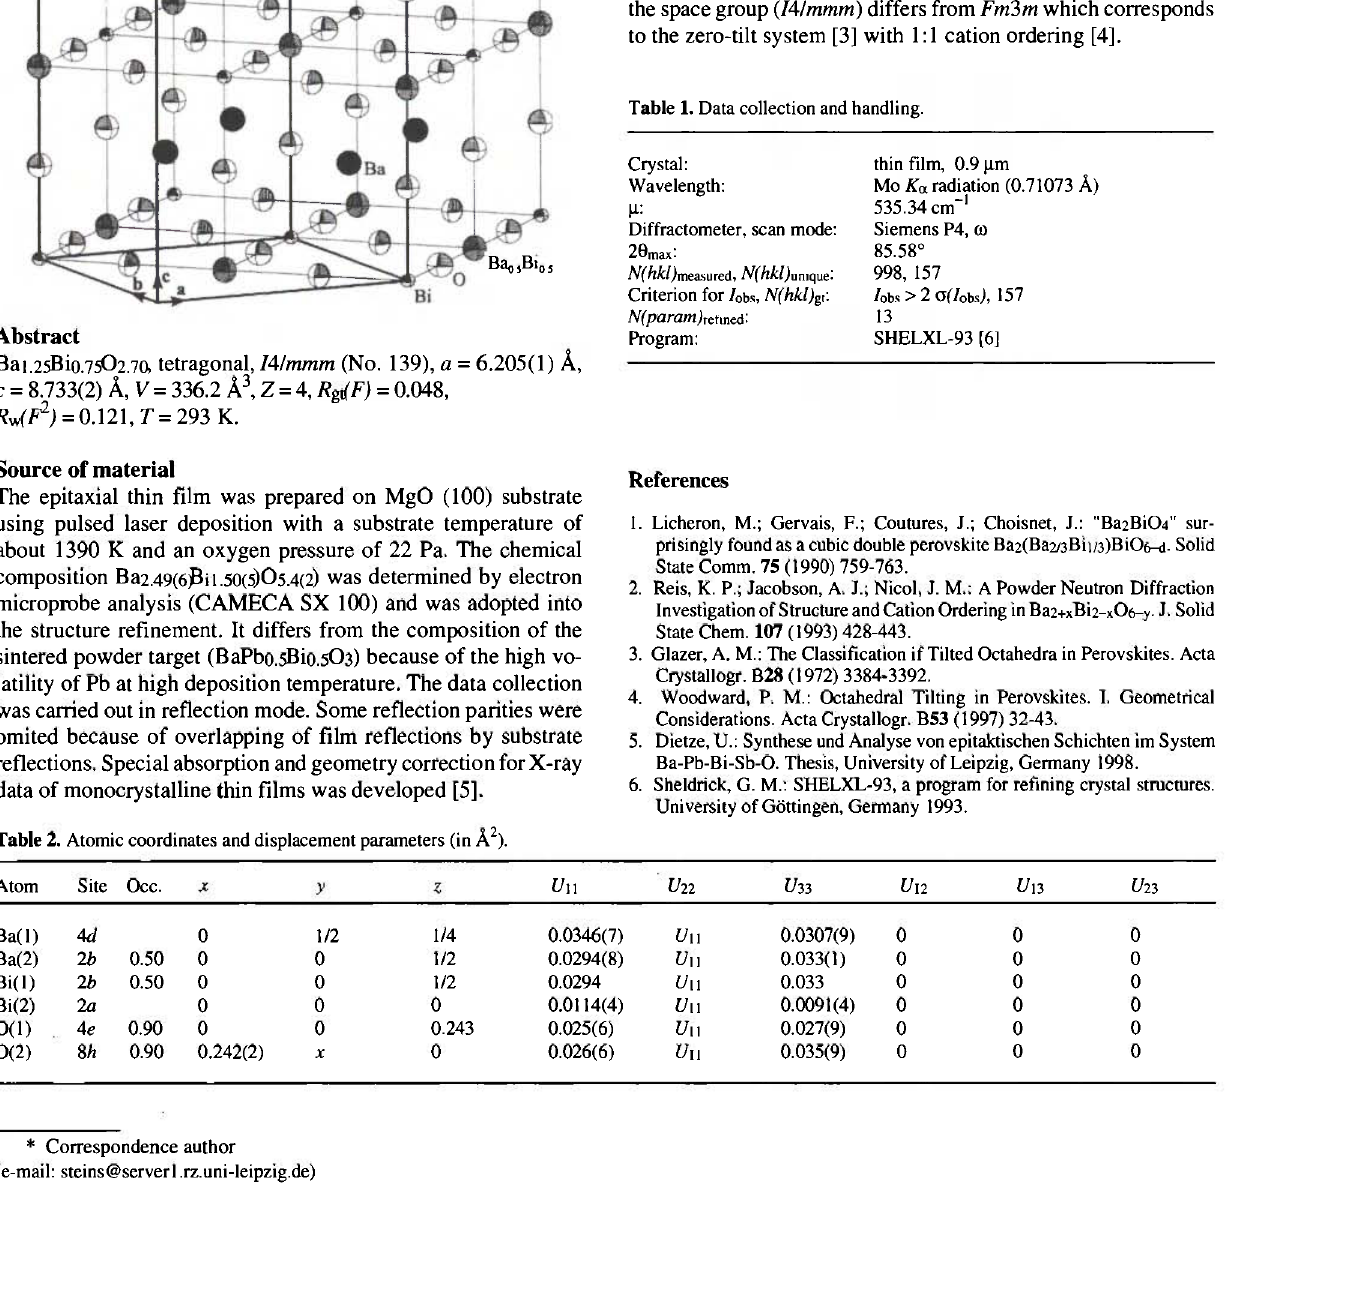
Table 1. Data collection and